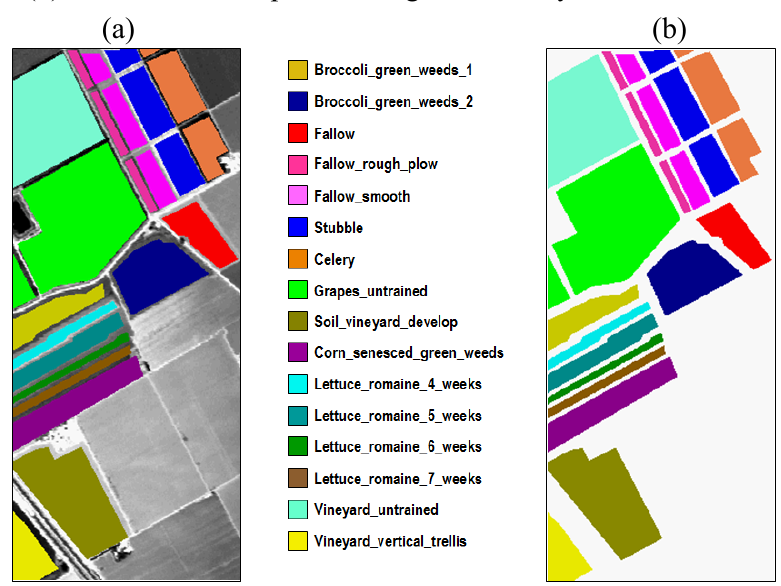
Figure 6. (a) Spectral band at 488 nm of an AVIRIS hyperspectral image comprising several agricultural fields in Salinas Valley, California, with ground-truth classes superimposed. (b) Ground-truth map containing 15 mutually exclusive land-cover classes.